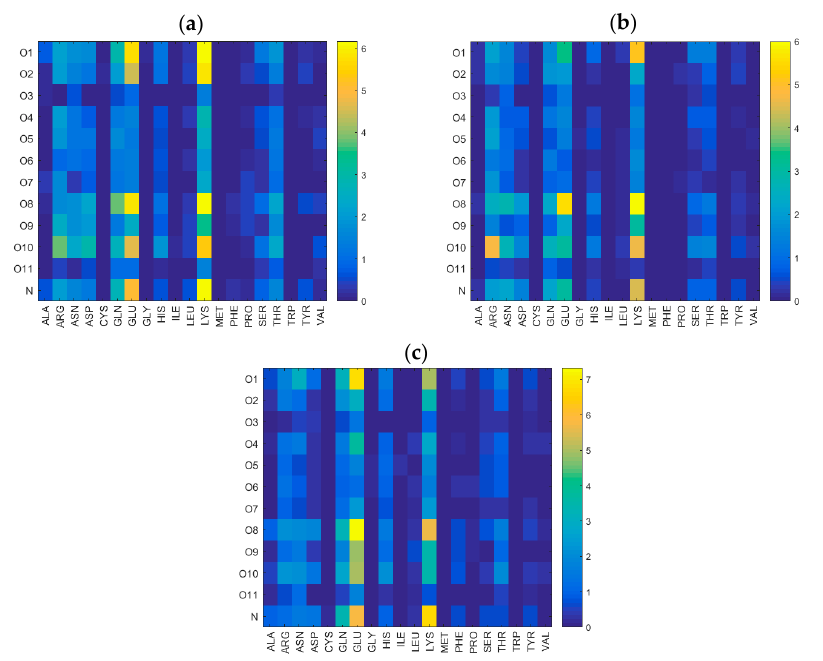
Figure 7. Hydrogen bond distribution between different oxygen classes in HA and different amino acids in HSA. Data were obtained in solutions containing ( a ) Na + , ( b ) Ca 2+ , ( c ) Mg 2+ . In all cases, Cl − was the anion.